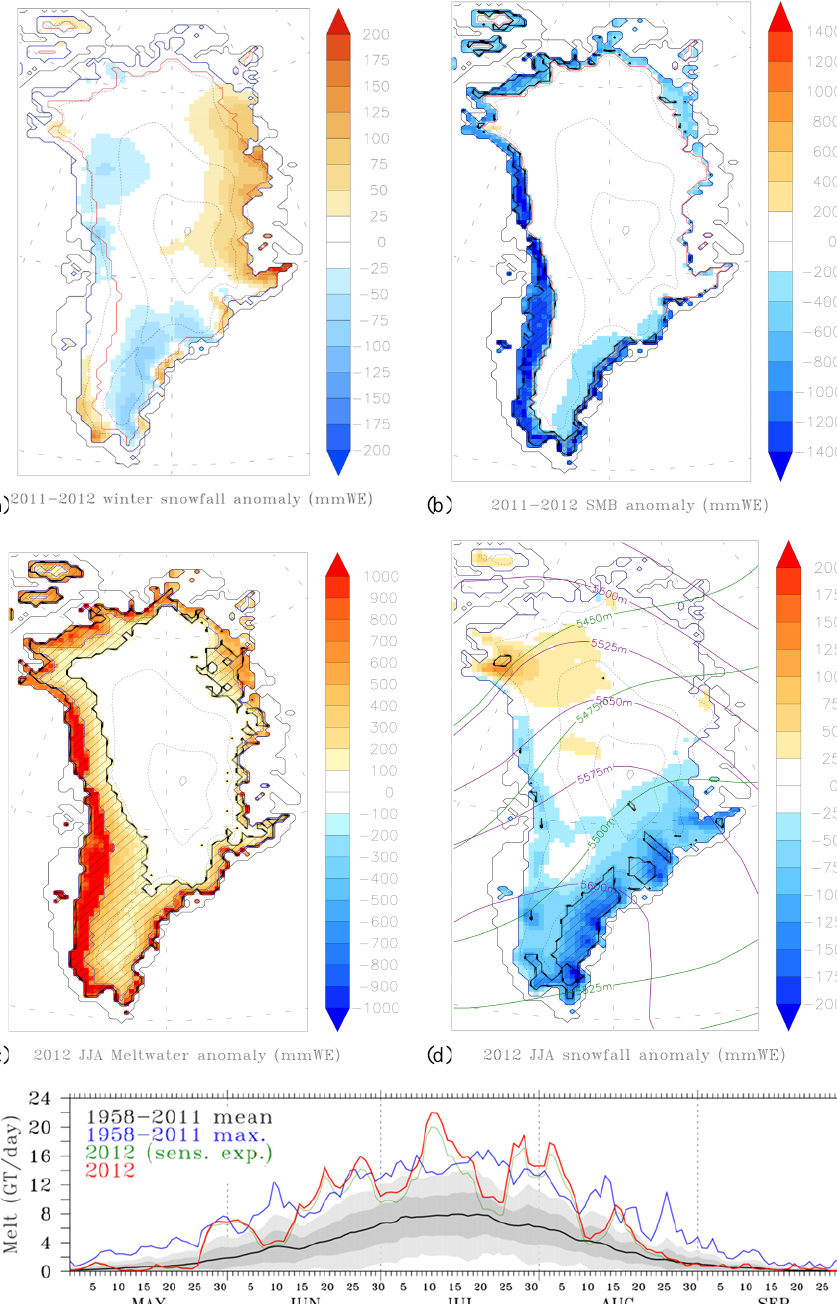
Fig. 6. (a) 2011–2012 winter accumulation anomaly (in mmWE) simulated by MAR with respect to 1958-2011. (b) 2012 SMB anomaly integrated over the hydrological year simulated by MAR with respect to 1958–2011. The 2011–2012 ELA (equilibrium line altitude) is plotted as a red line, and areas where the anomalies are at least twice the 1958–2011 standard deviation of MAR forced by ERA-INTERIM are hatched in black. (c) Same as (b) but for the JJA meltwater production. Only about 40–50% of this meltwater reaches the ocean by runoff. The ELA is plotted in blue here. (d) Same as (b) but for the JJA snowfall. (e) Time series (in red) of the 2012 GrIS cumulative meltwater production simulated by MAR. The same simulation starting 1 May 2012 with the state of the snow pack from May 1997 is plotted in green for the purpose of a sensitivity analysis. The 1958–2011 mean simulated by MAR is plotted in black. The dark and light gray areas correspond to the 1958–2011 standard deviation and, respectively, 2 times the standard deviation of the GrIS MAR simulated values. Finally, the absolute daily maximum values over the considered period are plotted in